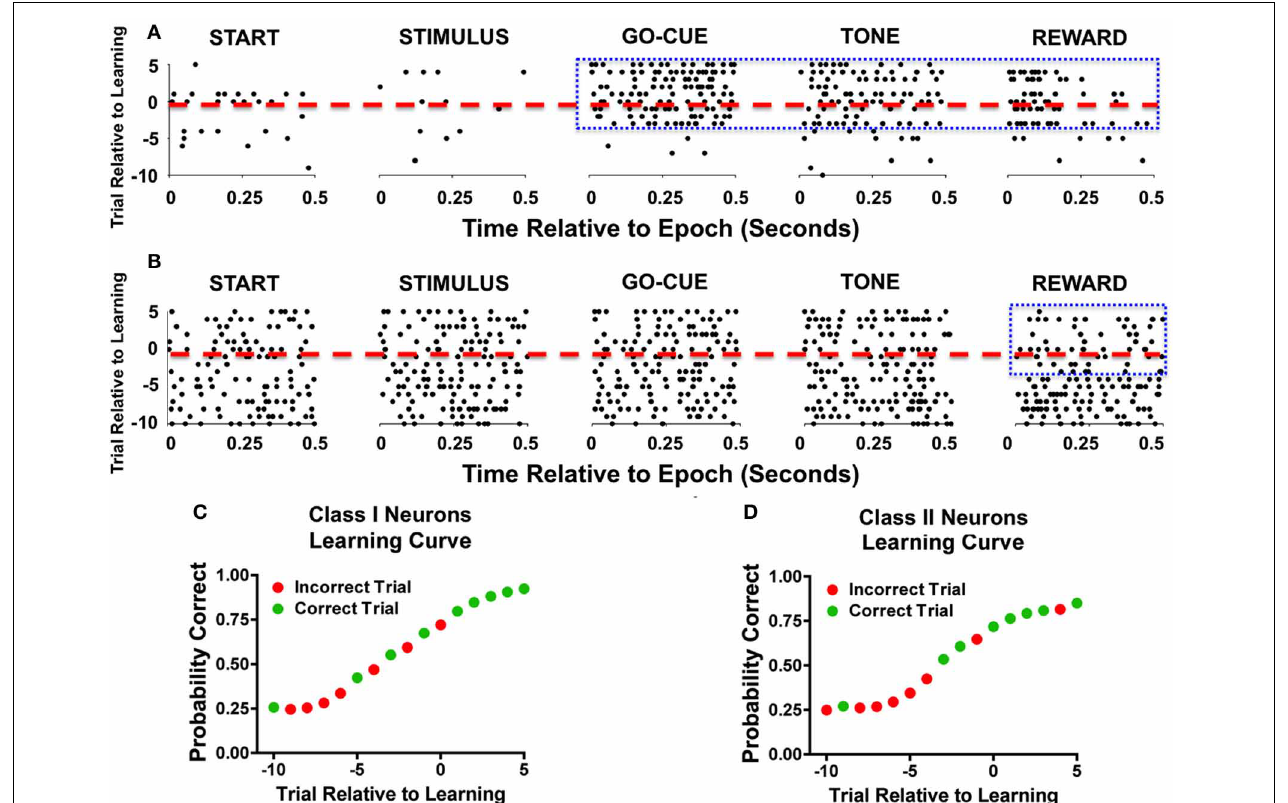
FIGURE 2 | Representative examples of individual neurons during learning. (A) Raster illustration of a Class I neuron during a single learning event. The y-axis represents the trial number relative to learning (dashed red line represents criterion trial), and the x-axis represents the time relative to the start of the epoch. As seen during the go-cue, feedback/ tone, and reward periods there is an increase in activity (enclosed blue box). (B) A representative example of a Class II neuron during a single